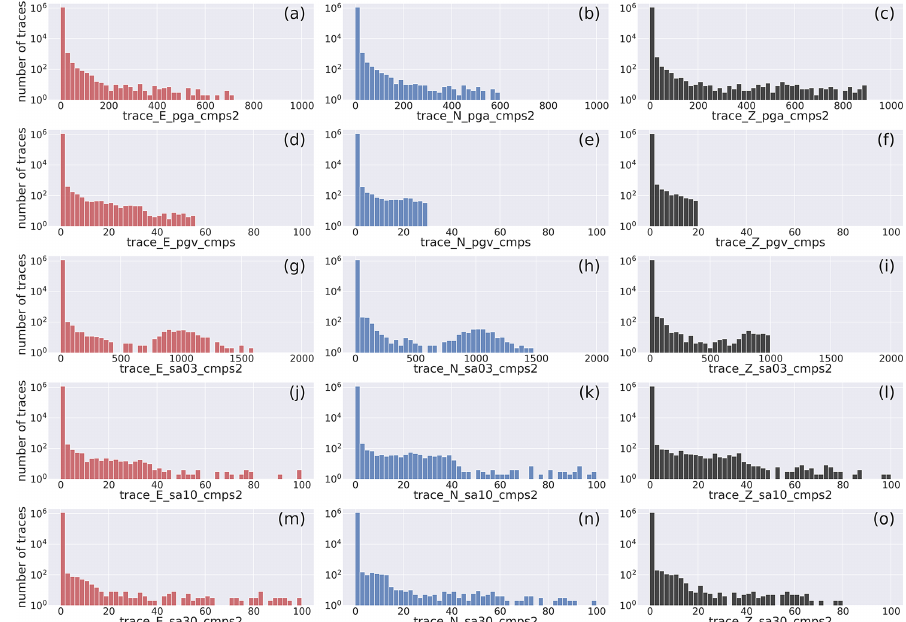
Figure D4. Histograms of the distribution of the intensity measures (IMs) of the earthquake dataset for M ≥ 2 earthquakes, with the hori- zontal axis inclusive of the complete range of values. Axes are labeled according to the metadata listed in Table 2.